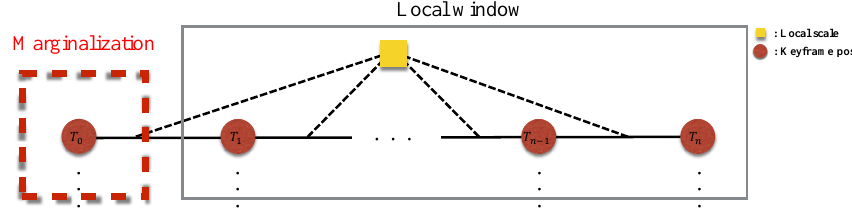
Figure 7. Marginalization of the old keyframes with local scale. Marginalized measurements are used as the prior for the next